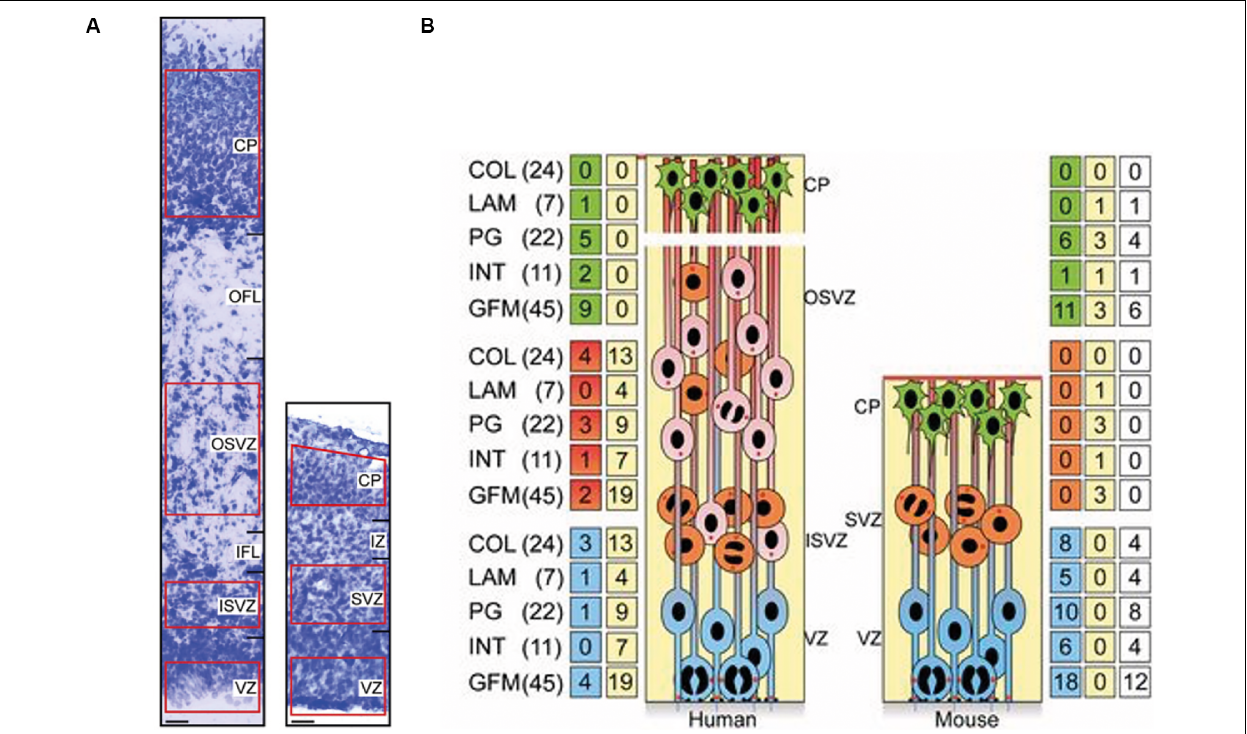
FIGURE 1 | Increased expression of extracellular matrix (ECM) components in the proliferative zones of the human fetal neocortex compared to the embryonic mouse neocortex. (A) Nissl staining of the cortical wall of a 15 post-conception week (pcw) human fetal neocortex (left) and of an embryonic day (E) 14.5 embryonic mouse neocortex (right). Scale bars represent 20 µ m. The areas used for transcriptomic analysis are highlighted in red. The different zones of the cortical wall are labelled as ventricular zone (VZ), subventricular zone (SVZ), inner SVZ (ISVZ), outer SVZ (OSVZ), inner fibre layer (IFL), outer fibre layer (OFL), intermediate zone (IZ) and cortical plate (CP). (B) Schematic illustrating the major cell types within the developing cortical wall (APs = blue, BPs = orange and red, neurons = green) and the distribution of ECM and ECM-associated components within these areas. The major families of ECM components are the collagens (COL), laminins (LAM), proteoglycans (PG), integrins (INT) and growth factors/morphogens (GFM). Numbers in parentheses indicate the total numbers of genes within each family. Numbers in the green/red/blue boxes indicate the number of genes overexpressed in the adjacent area. Numbers in the yellow boxes indicate the number of genes that are overexpressed in more than one human or mouse zone. Numbers in the white boxes indicate the number of genes that are overexpressed in both humans and mice. The cells within the zones are: APs are located within the VZ in both mice and humans, BPs are located in the SVZ in mice, and within the ISVZ and OSVZ in humans, neurons are located in the CP in both species. Adapted from Fietz et al.